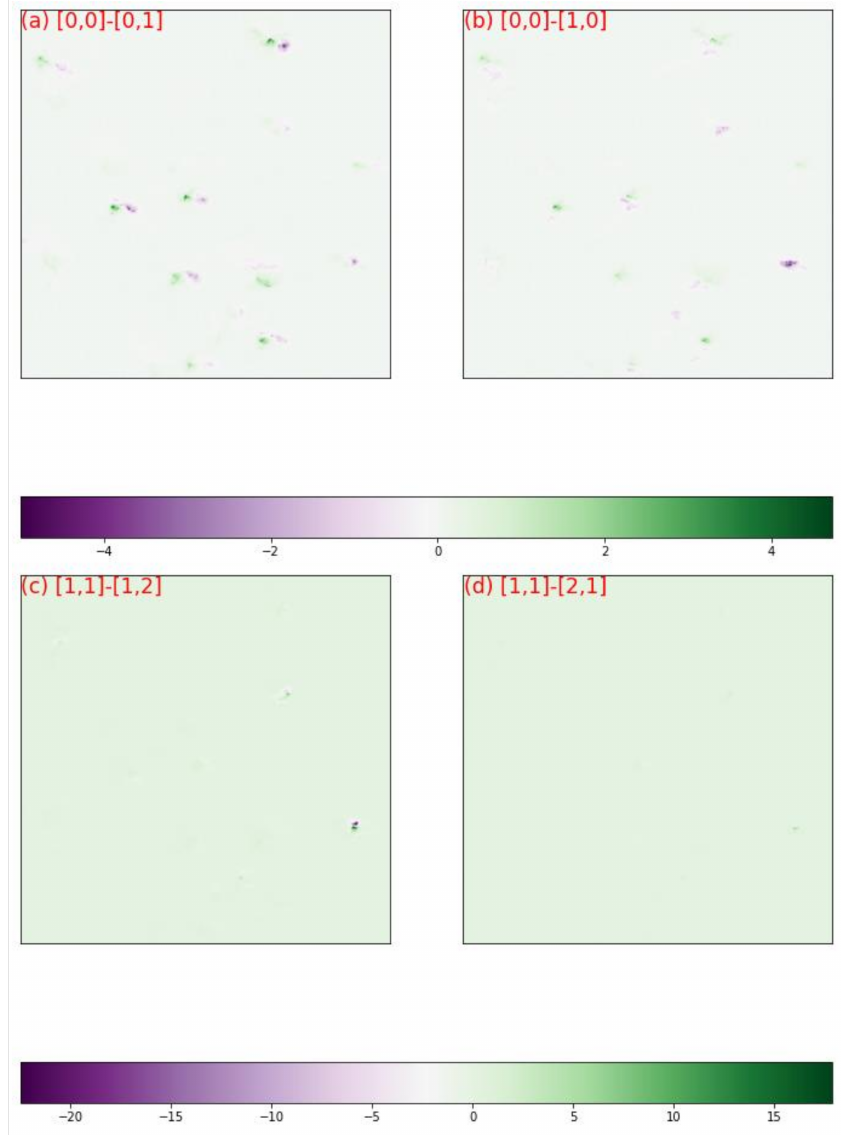
Figure 9. The discrepancy map between the normalized images in Figure 8, ( a ) between [0,0] and [0,1]; ( b ) between [0,0] and [1,0]; ( c ) between [1,1] and [1,2]; ( d ) between [1,1] and